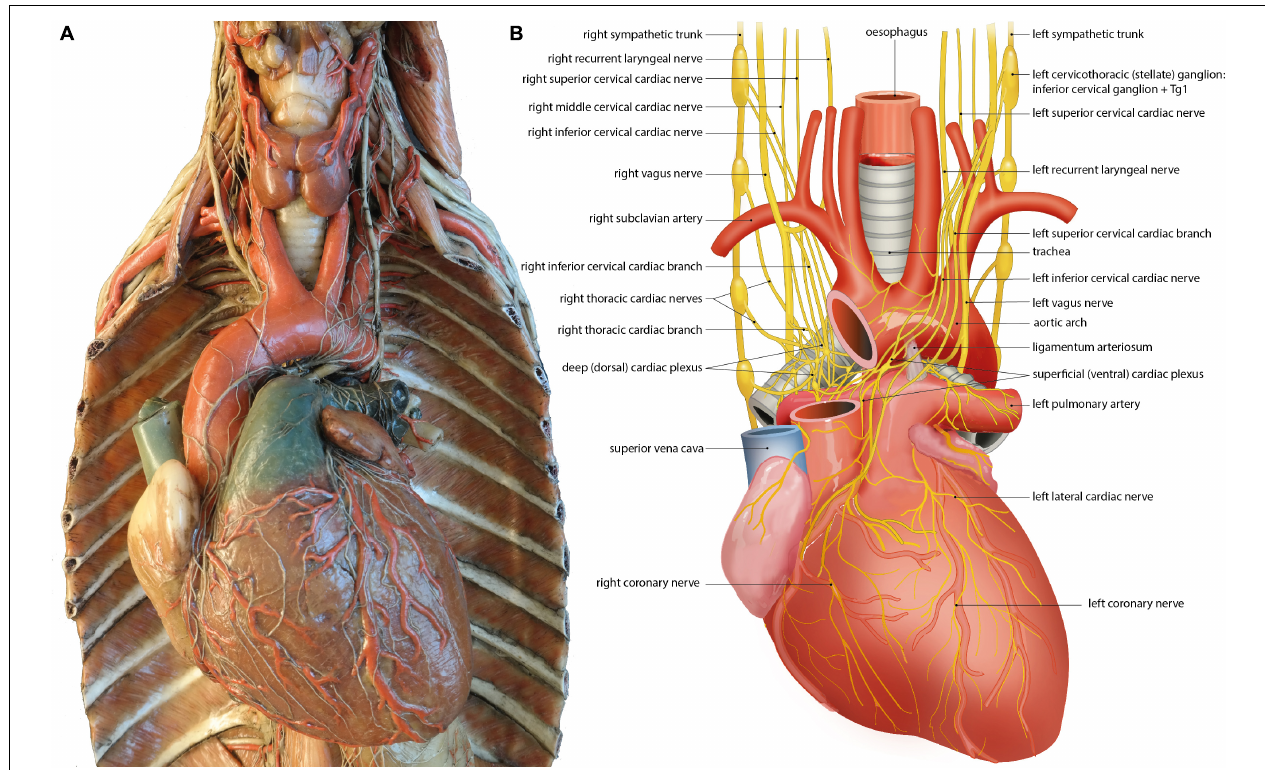
FIGURE 3 | The left and right cardiac nerves and superficial and deep cardiac plexus. (A) Wax mold (Museo delle Cere Anatomiche “Luigi Cattaneo”, Bologna, Italy) demonstrating sympathetic and parasympathetic (vagal) cardiac nerves and superficial and deep cardiac plexus. Photomicrograph courtesy of Dr. E.A.J.F. Lakke. With permission of the Museo delle Cere Anatomiche “Luigi Cattaneo”, University Museum System, Alma Mater Studiorum – University of Bologna, Italy. (B) Annotated drawing, details depiction of cardiac nerves and plexus depicted in the left panel. At the heart sympathetic and parasympathetic nerves converge to form the superficial and deep cardiac plexus from which atrial and ventricular autonomic innervation is arranged. For further explanation see text.